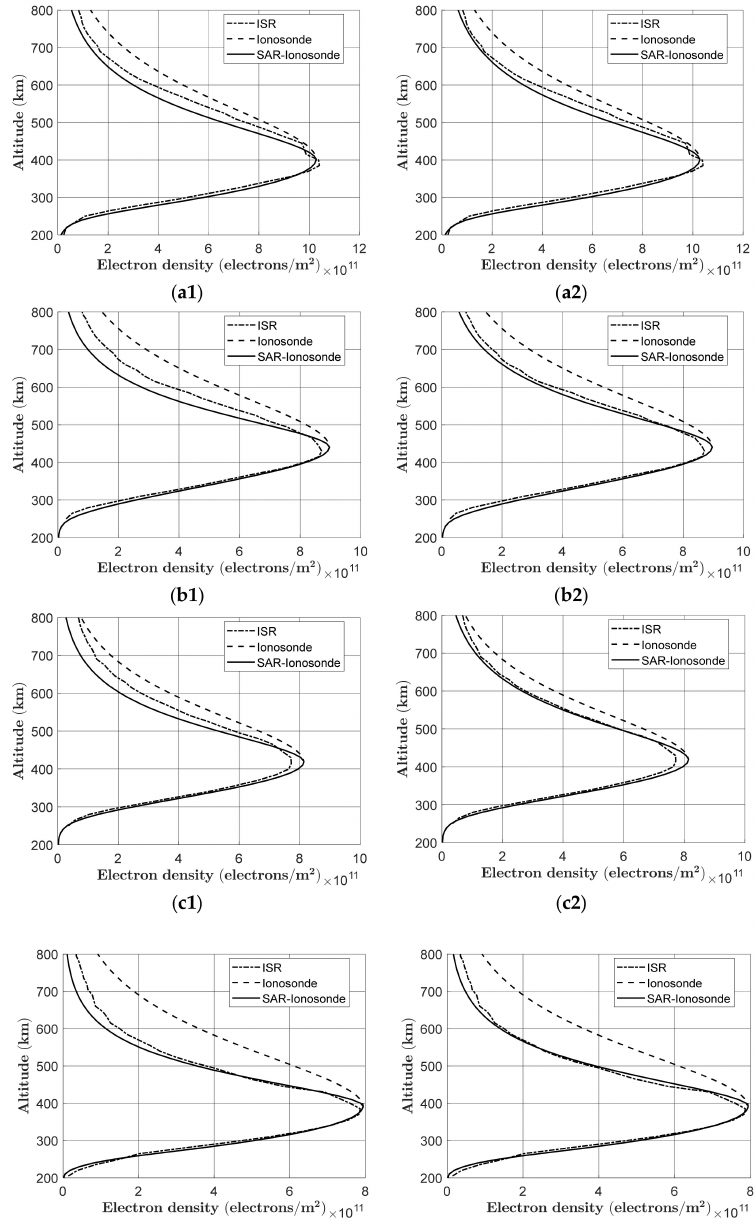
Figure 8. Combined retrieval of electron density using four groups of L-band and P-band SAR and the ionosonde with high systematic errors. Figure ( a1 – d1 ) in the left column are results of L-band from 23:00 to 02:00 12 June 2002. Figure ( a2 – d2 ) in the right column are results of P-band from 23:00 to 02:00 12 June